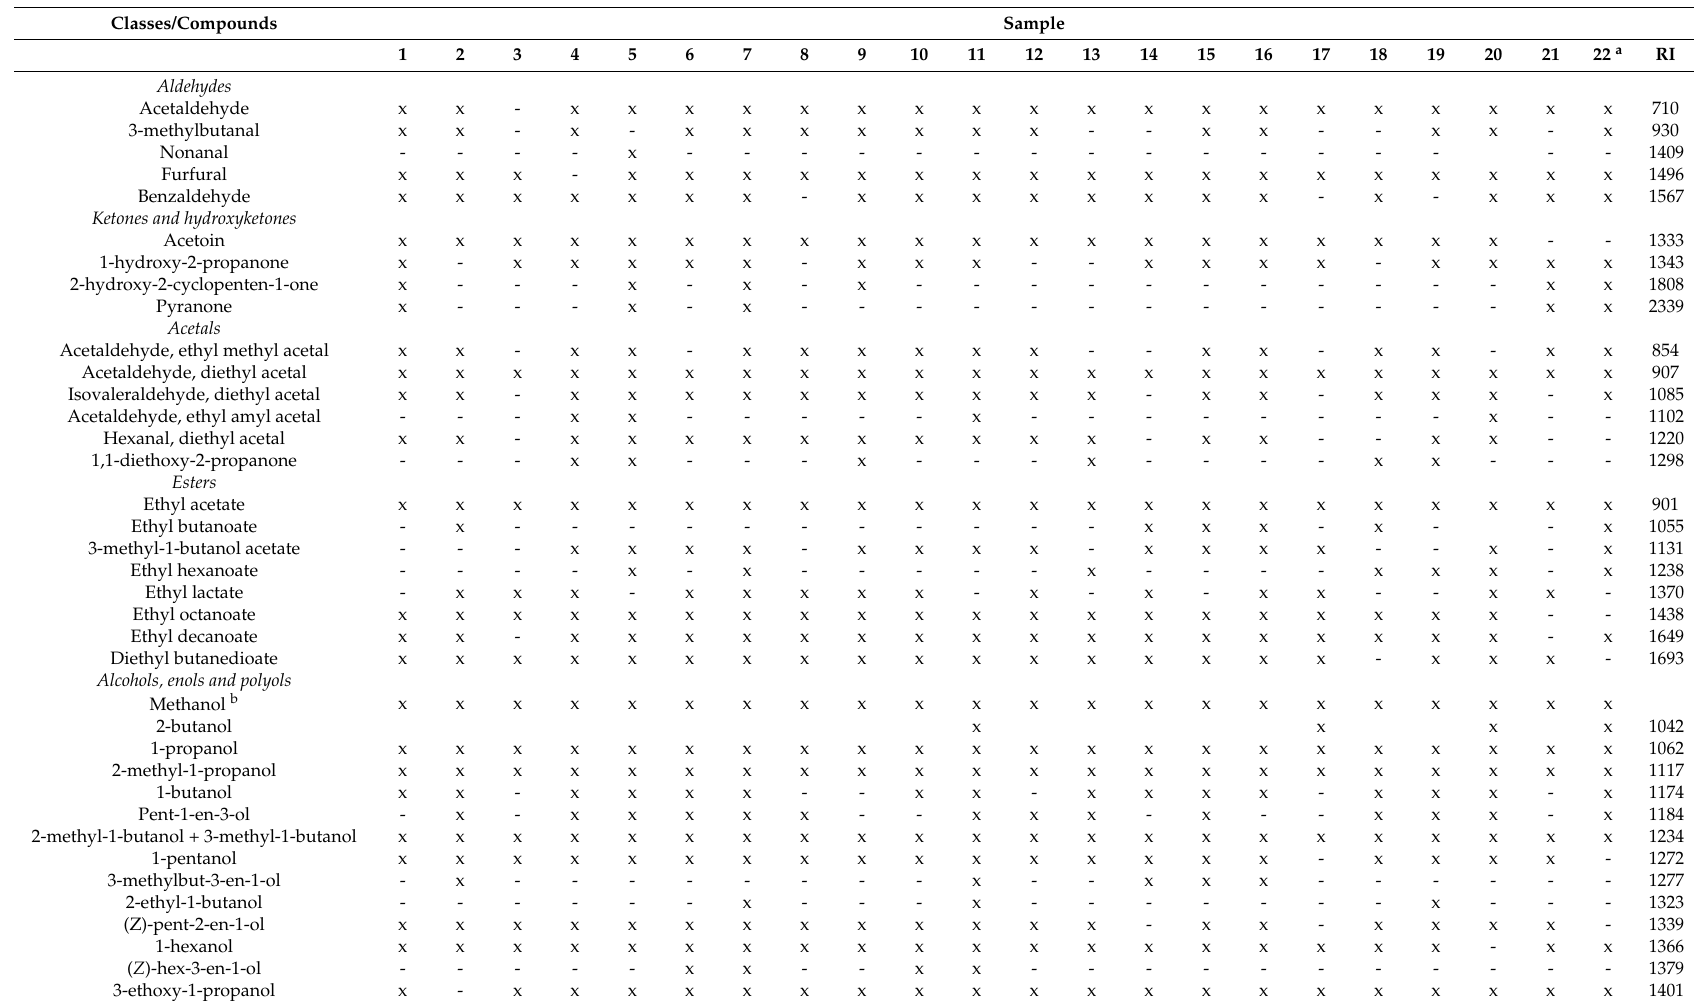
Table 5. GC-MS qualitative attribution of volatile compounds in Filuferru